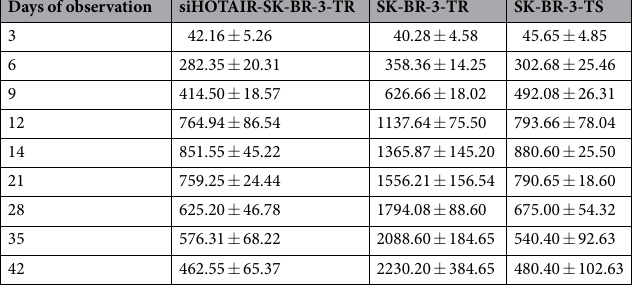
Table 1. Size (mm 3 ) of tumors before trastuzumab intervention.